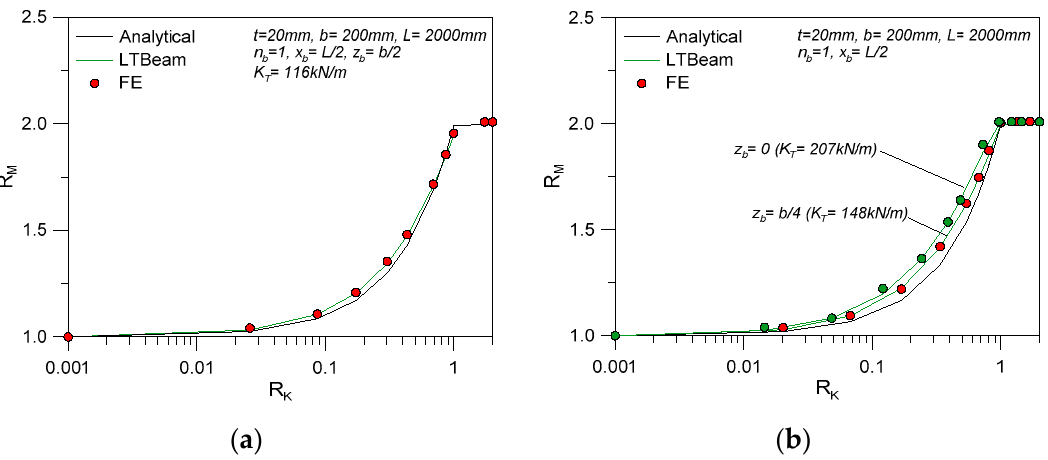
Figure 15. Comparative LTB calculations for LR glass beams with discrete lateral restraints ( n b = 1) at different positions z b ( K = var): ( a ) z b = b /2 and ( b ) z b = 0, b /4.